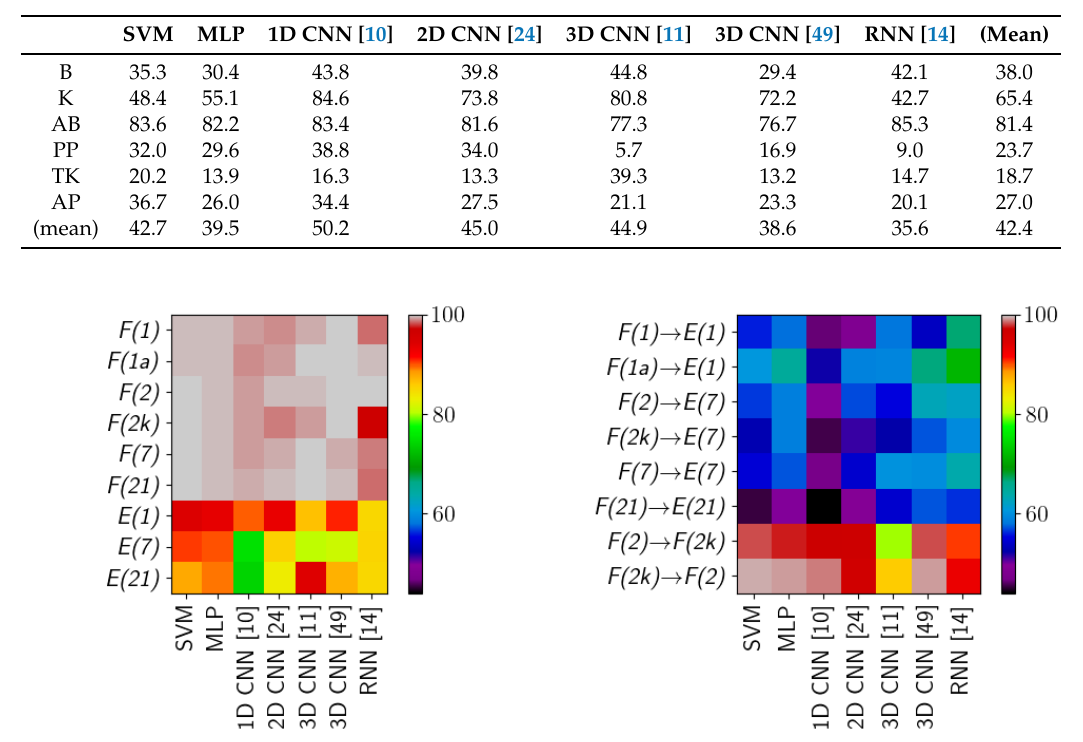
Table 6. Per-class percentage of errors for each method, aggregated over inductive experiments with F(i) → E(j) images (first part of the HIC experiment).